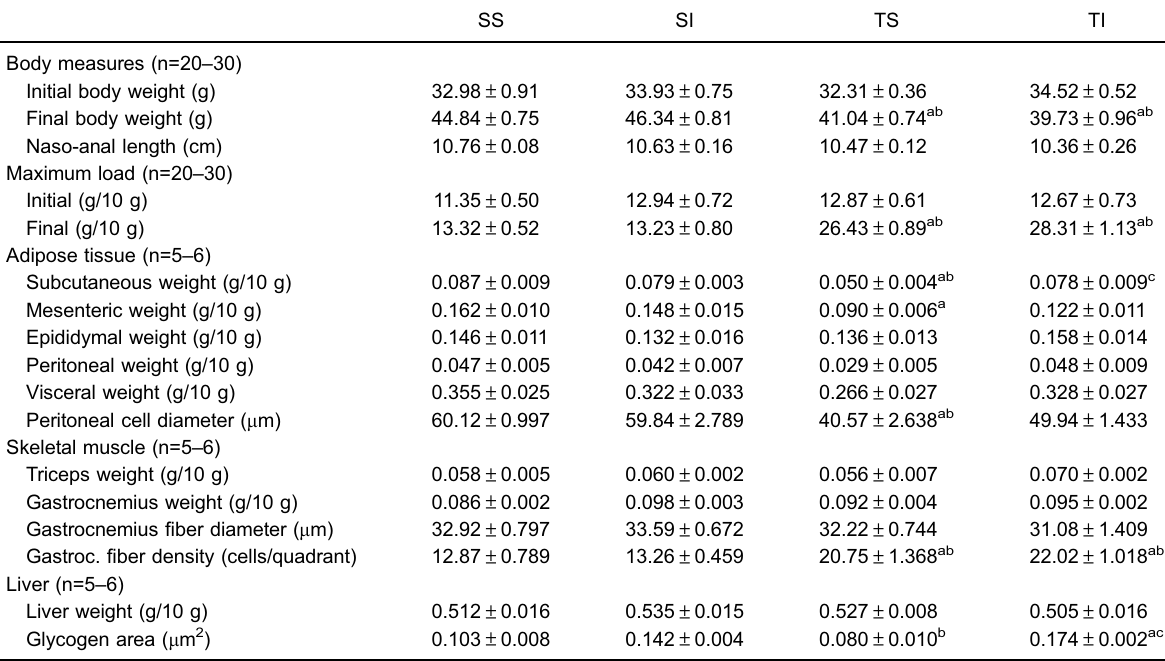
Table 1. Quantitative data of Swiss mice of groups SS: sedentary treated with saline; SI: sedentary treated with insulin; TS: trained treated with saline; and TI: trained treated with insulin. SS SI